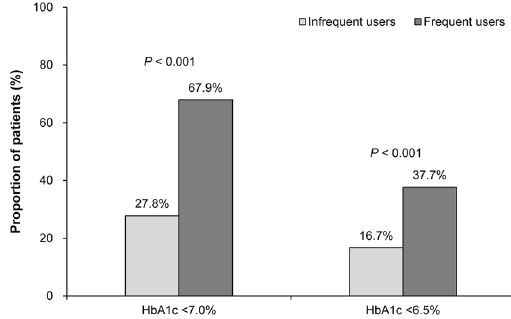
Figure 1. Proportion of patients achieving target HbA1C at 6 months.